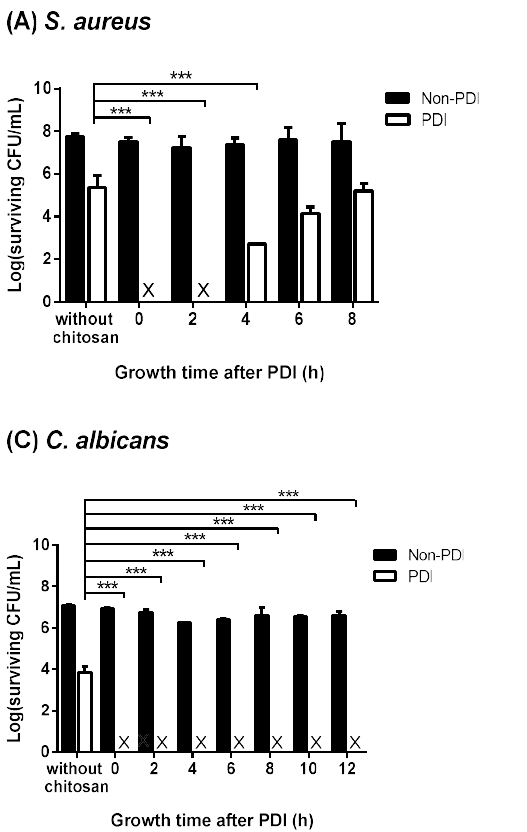
Figure 6. Chitosan inhibits the recovery of the PDI surviving cells. For PDI, 15 µ M and 20 µ M TBO was incubated with ( A ) S. aureus and ( B ) P. aeruginosa , respectively. ( C ) For C. albicans , 400 µ M TBO was used for PDI. After light irradiation (50 J cm − 2 ), cells were sub-cultured in a fresh liquid medium. Chitosan was then added at the time indicated and further incubated for 30 min. After incubation, cells were washed with phosphate-buffered saline (PBS) and plate counts were performed. Each value is the mean obtained from three independent experiments ± SD, X represents the complete killing of cells, and *** p < 0.001.